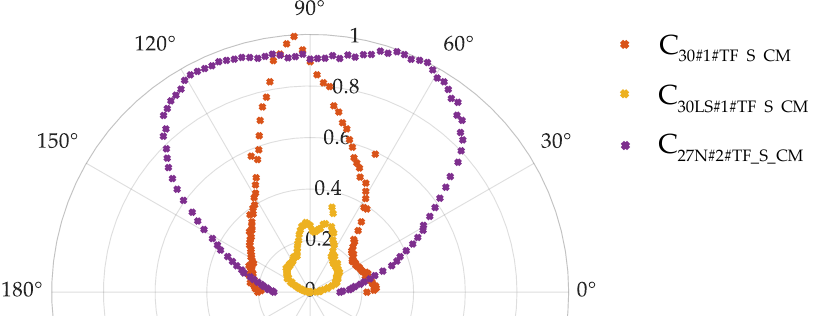
Figure 5. Polar charts of the selected time-frequency feature (the concentration measure BN CM ) extracted from MBN spectrograms obtained for various samples; the presented angular characteristics were normalized according to the greatest and smallest value in the set.